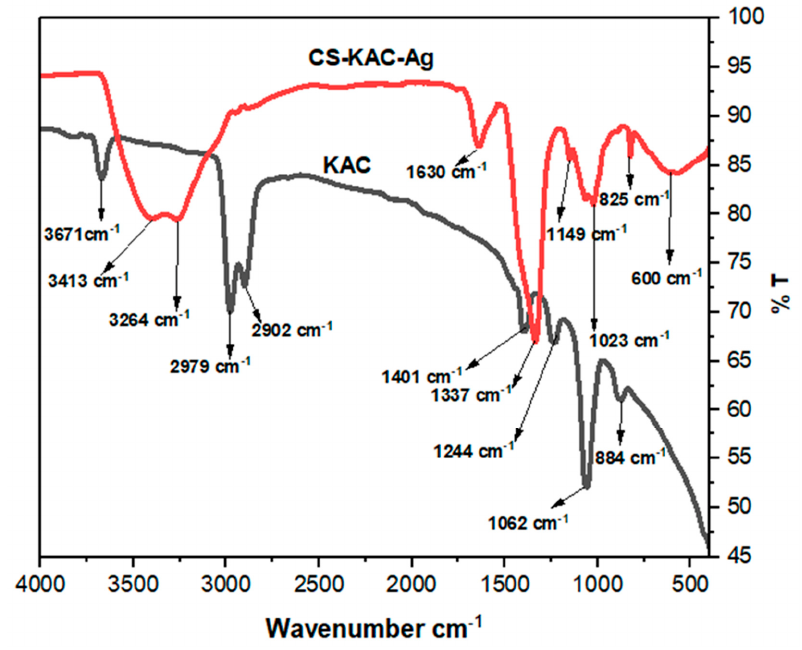
Figure 4. FTIR spectra of KAC and CS ‐ KAC ‐